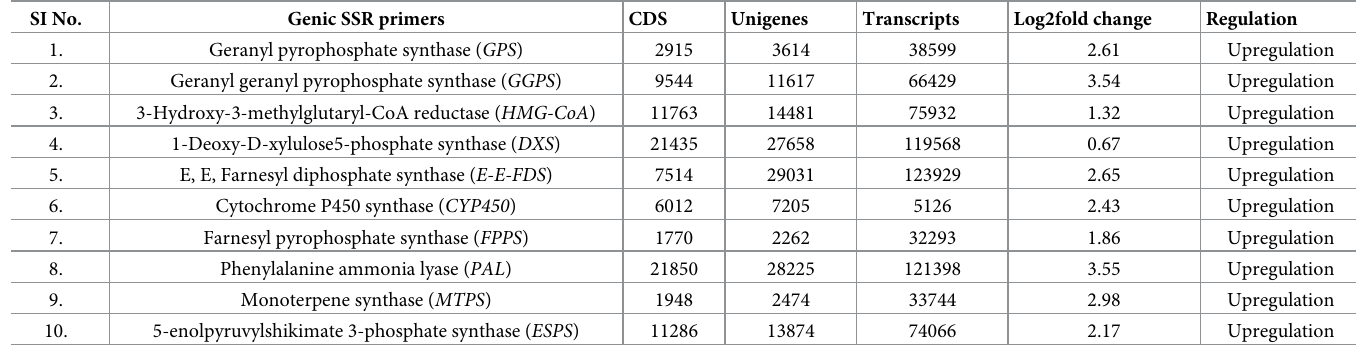
Table 8. Relative expression of high oil yielding ( Sa SHc) genes, coding sequence, unigenes, transcripts, log2 fold change and regulation. SI No.